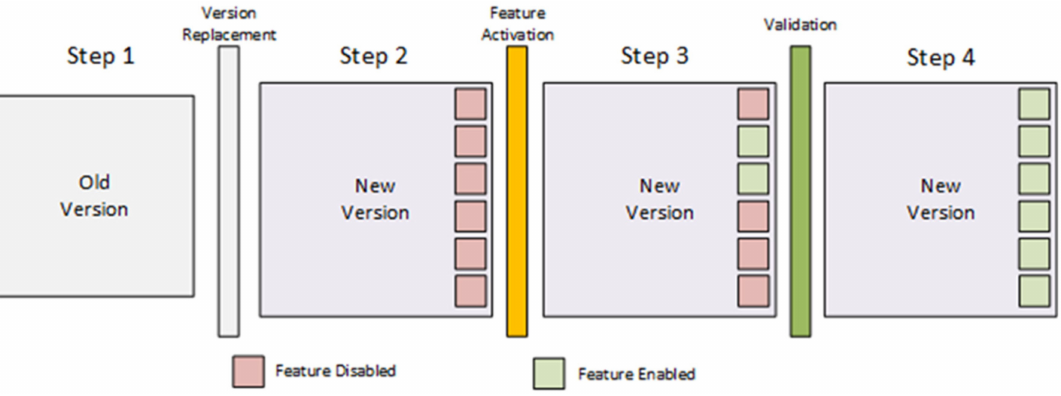
Figure 3. Dark launch and feature flags.